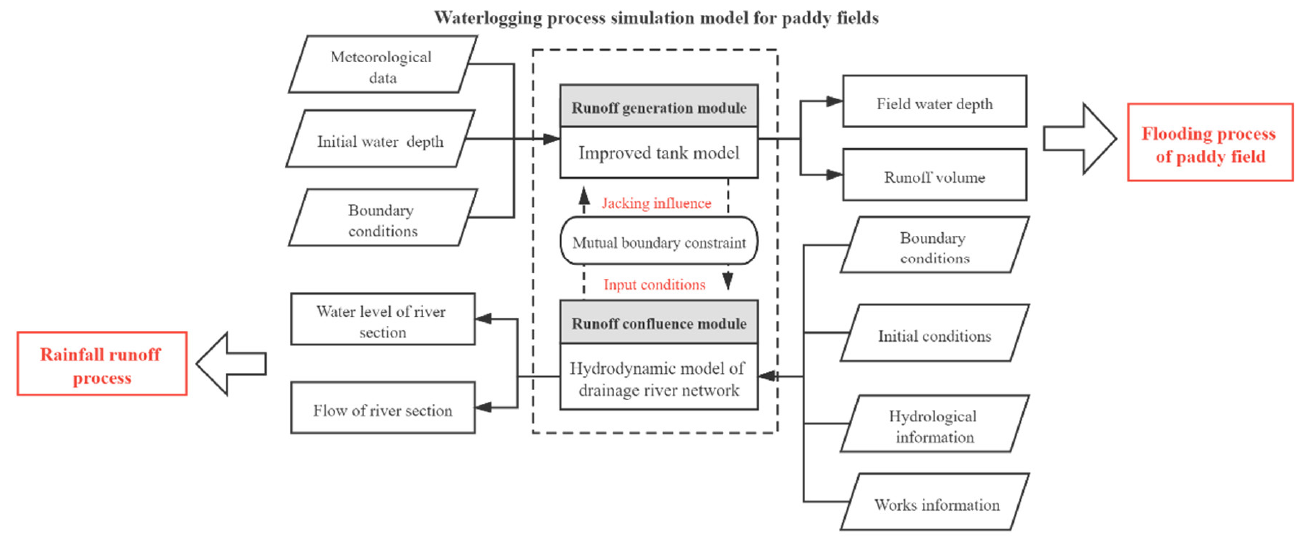
Figure 4. Structure of the waterlogging process simulation model.